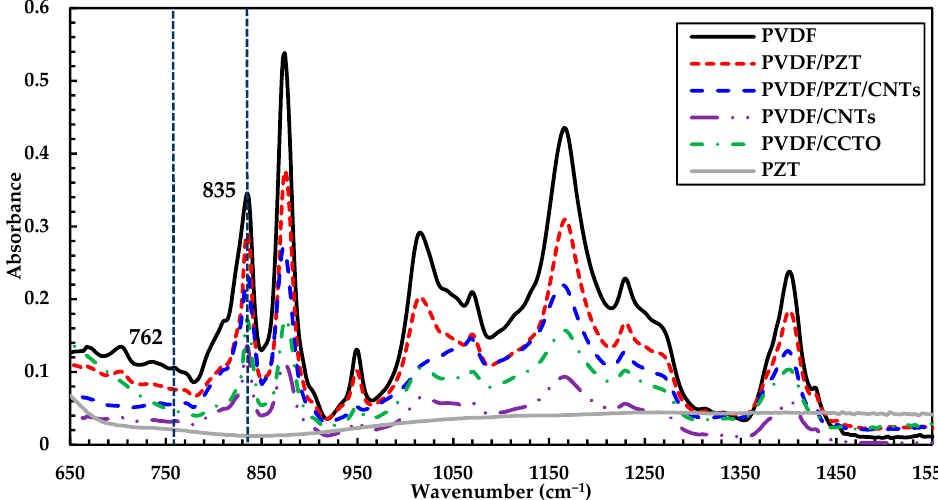
Figure 3. FT-IR absorbance spectra of different fillers with PVDF Figure 3. FT ‐ IR absorbance spectra of different fillers with PVDF polymer.